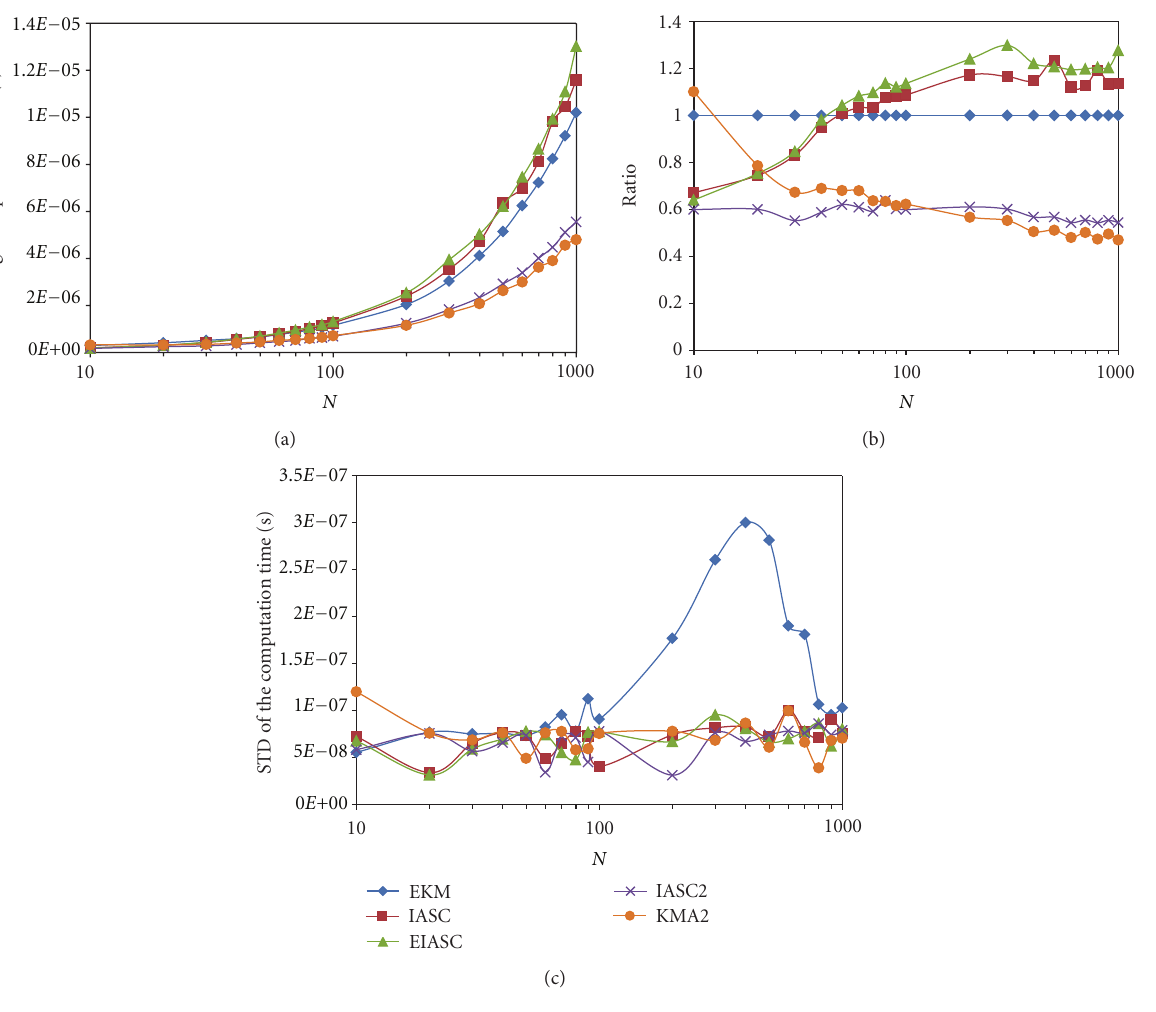
Figure 4: Centered random FOU results (compiled language implementation of the algorithms). (a) Average computation time, (b) ratio with respect to the EKMA, and (c) standard deviation of the computation